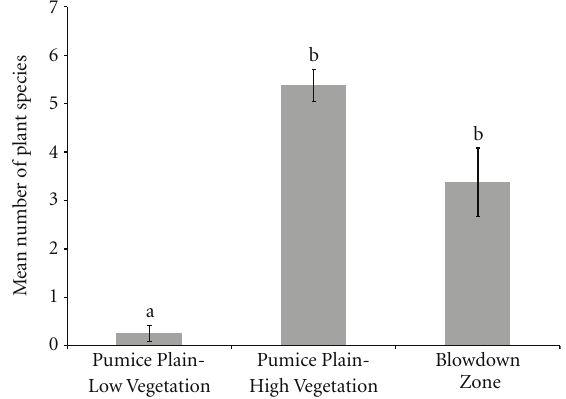
Figure 5: Richness (mean number of plant species ± 1 SE) of plant communities in three habitat types at Mount St. Helens National Volcanic Monument sampled between 22 and 25 July 2008. All plant species, including unidentified ferns and grasses (which were categorized to morphospecies), found within the 0.5 m 2 sampling quadrats were used in plant richness calculations. Di ff erent letters above the bars indicate significant di ff erences ( P < 0 . 01) between habitat types.